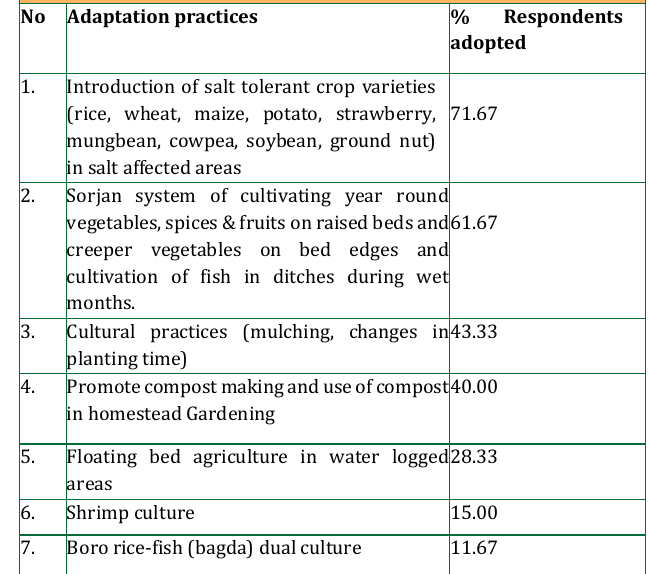
Table 5: Adaptation Practices for Sustainable Agricultural Production